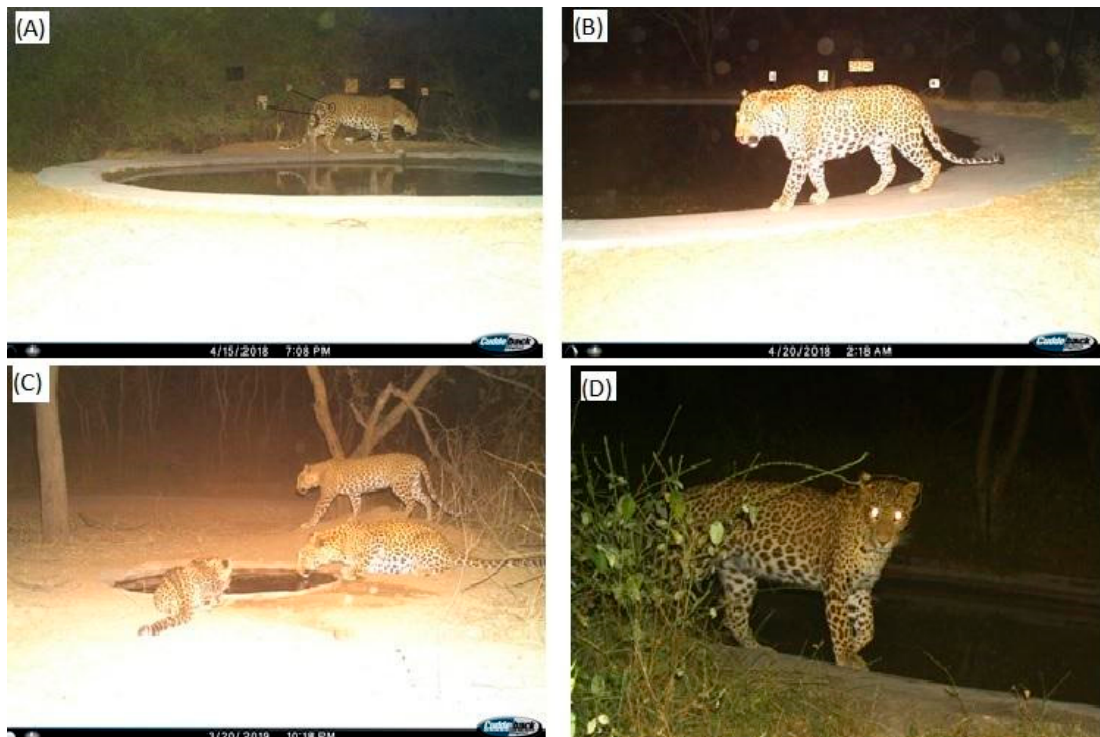
Figure 4. Camera trap images showing the sharing of resources and rosette/facial markings used to identify individuals at Jhalana Reserve Forest, India. The marked patterns on the flanks (Right flank ( A ), Left flank ( B )) are an example of the method used to identify an individual (Rambo, male).; ( C ) Adult female Jalebi sharing a waterhole with her mother Flora and her cub from a subsequent litter; ( D ) Facial marking of female Jalebi used for identification.